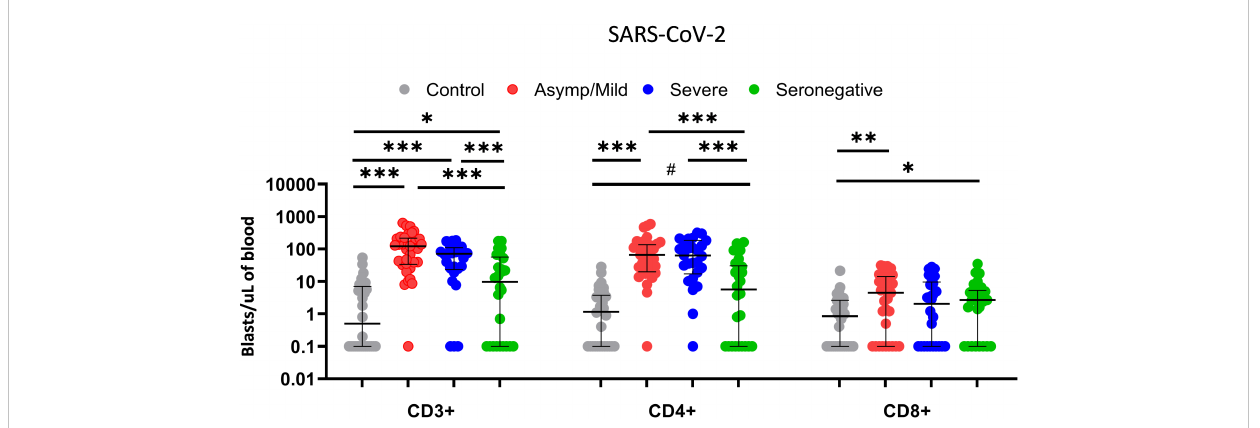
FIGURE 4 Comparison of T-cell proliferative response of CD3+, CD4+ and CD8+ T cells (blasts/µl of blood) between healthy controls (grey dots; n=30), asymptomatic/mild seropositive patients (red dots; n=33), severe seropositive patients (blue dots; n=26) and seronegative patients (green dots; n=26) after stimulation with SARS-CoV-2 using the FASCIA assay. Each dot represents an individual. Median and IQR are shown. The Mann – Whitney U test was used. # 0.054, *<0.05, **<0.01, ***<0.001.